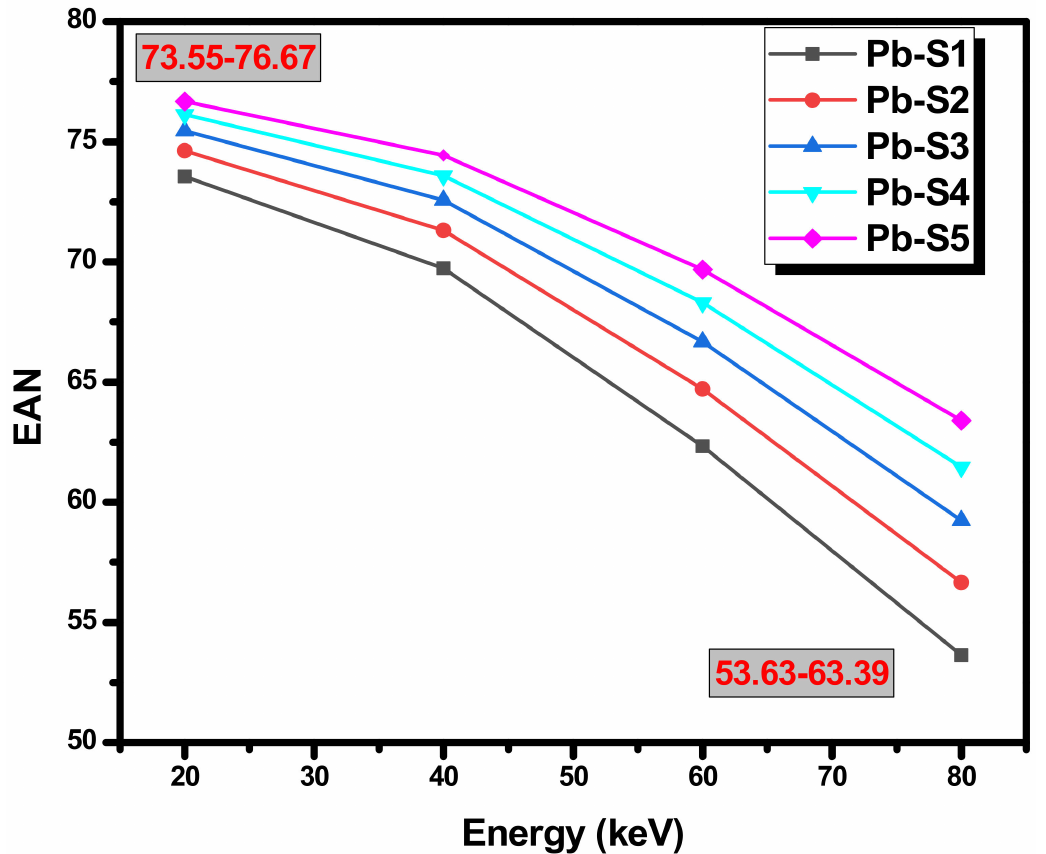
Figure 6. The EAN for the Pb-SX glasses at four energies (20, 40, 60 and 80